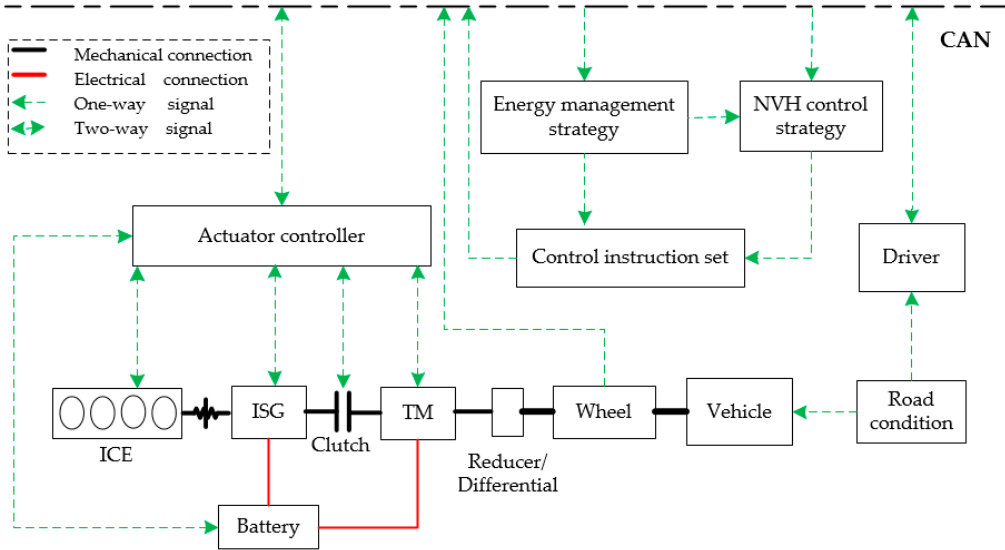
Figure 3. Simulation platform architecture.